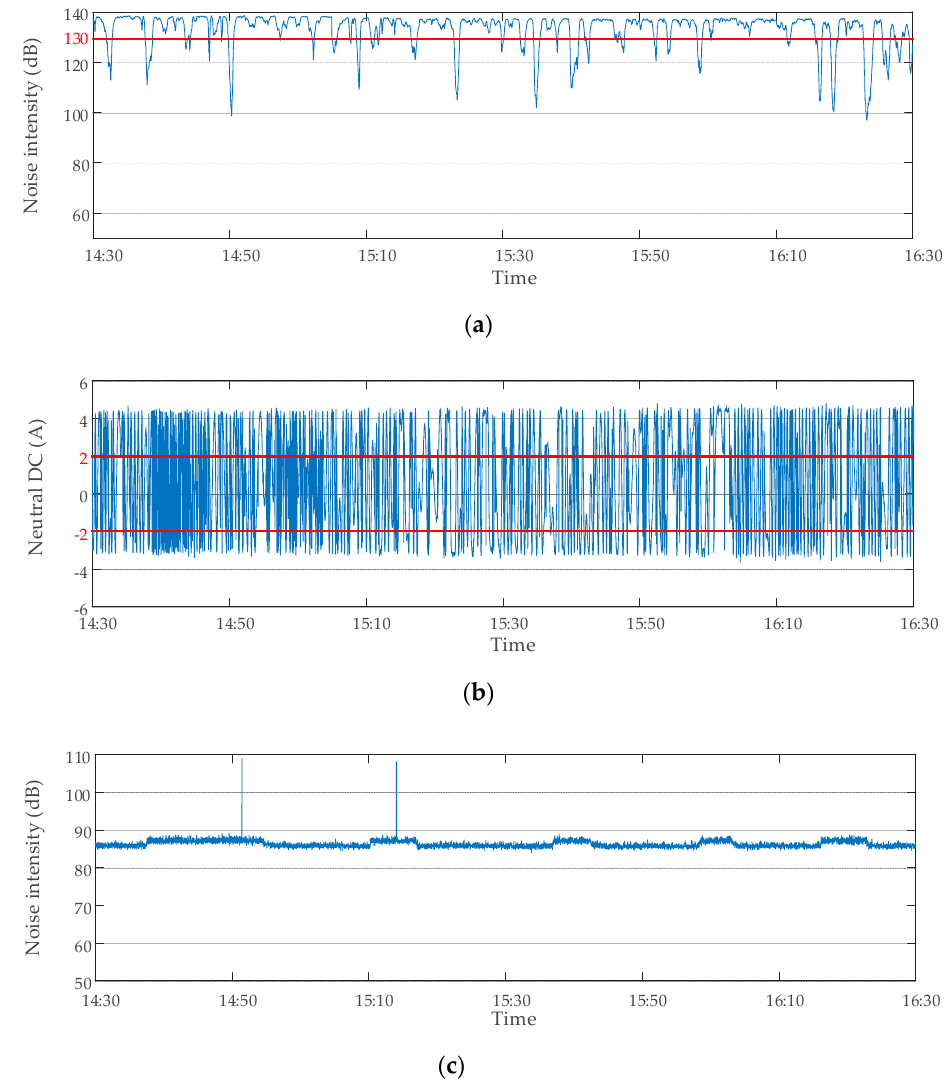
Figure 10. Several typical abnormal data: ( a ) noise overrange data caused by abnormal migration; ( b )